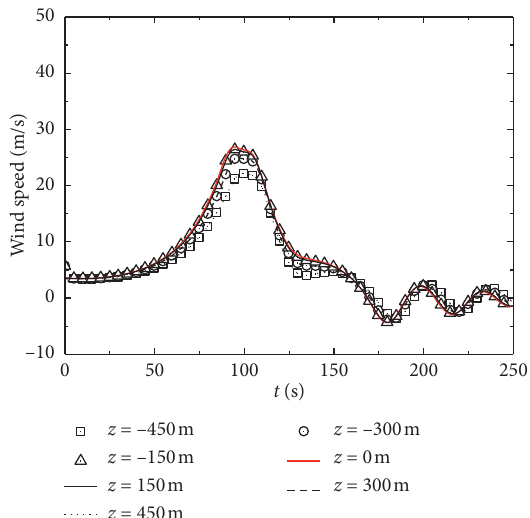
Figure 5: Time-history curves of horizontal wind speed in the flat terrain.